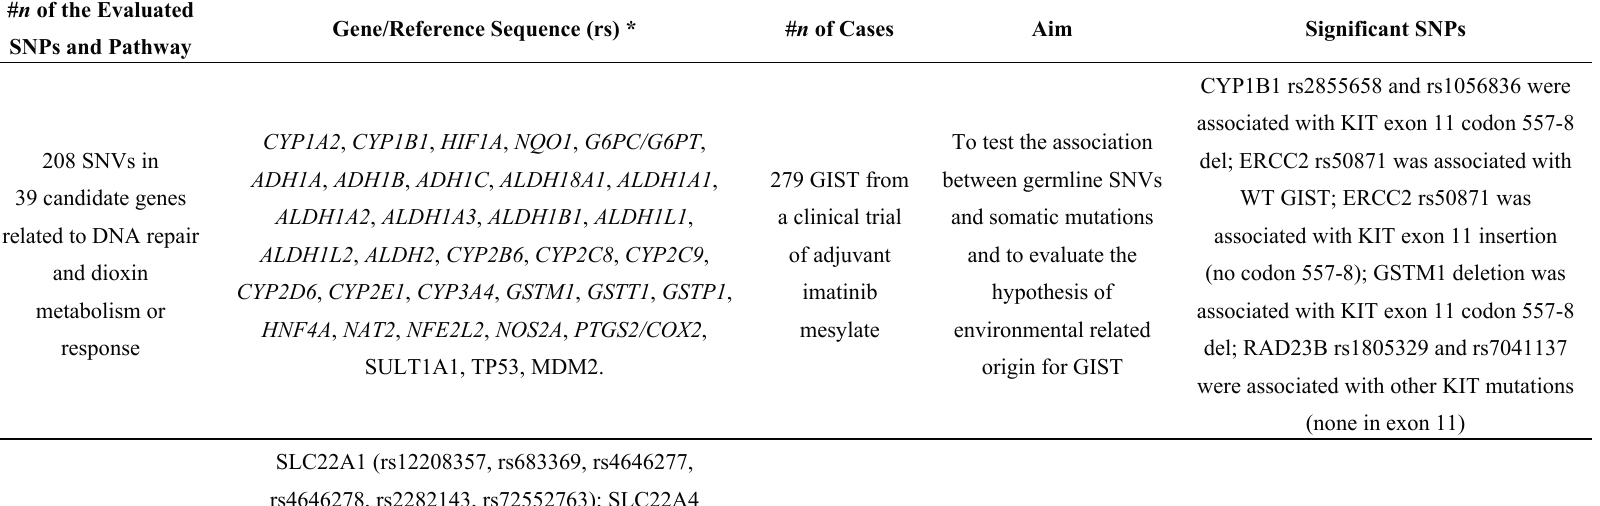
Table 1. Summary of the pharmaocogenetics